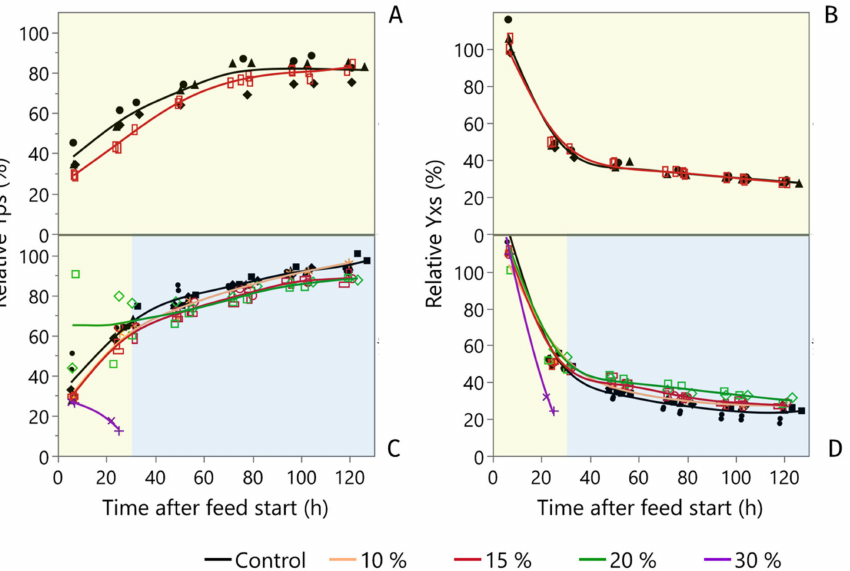
Figure 6. Relative product and biomass yields on glucose. ( A ) Product yield (Yps-2 (cid:48) -FL + DFL) and ( B ) biomass yield (Yxs), under C-limitation, ( C ) product yield and ( D ) biomass yield under C/N-limitation with different levels of CO 2 enrichment. Different marker types represent distinct replicate fermentations. The values were relativized by normalizing to the end-point value of the average of the three fermentations without CO 2 enrichment under C/N